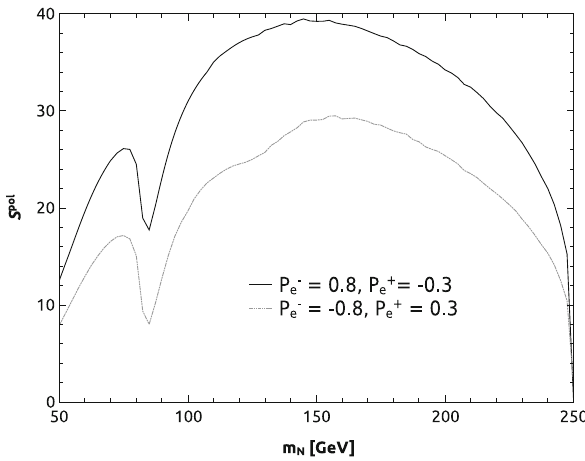
Fig. 7 Thepolarizationasymmetry S pol ( m N ) fordifferentinitialbeam